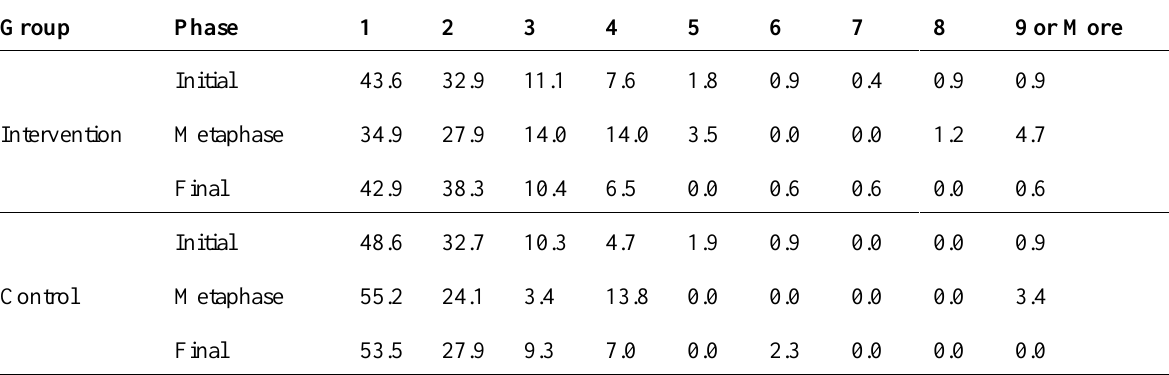
Table 8. Consumption frequency of western-style food monthly among parents